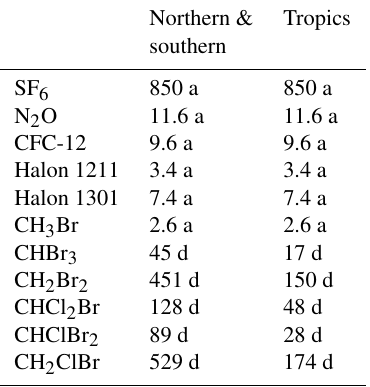
Table 2. Initial-guess effective lifetimes for all species in this study. The values are annual averages and taken from Ray et al. (2017), SPARC (2013) and Carpenter and Reimann